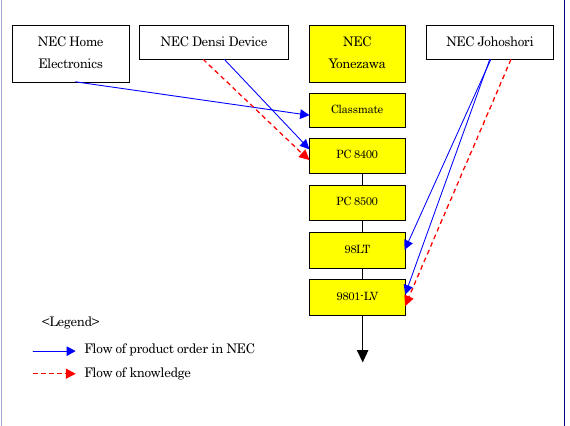
Figure2. Absorbing resources from other